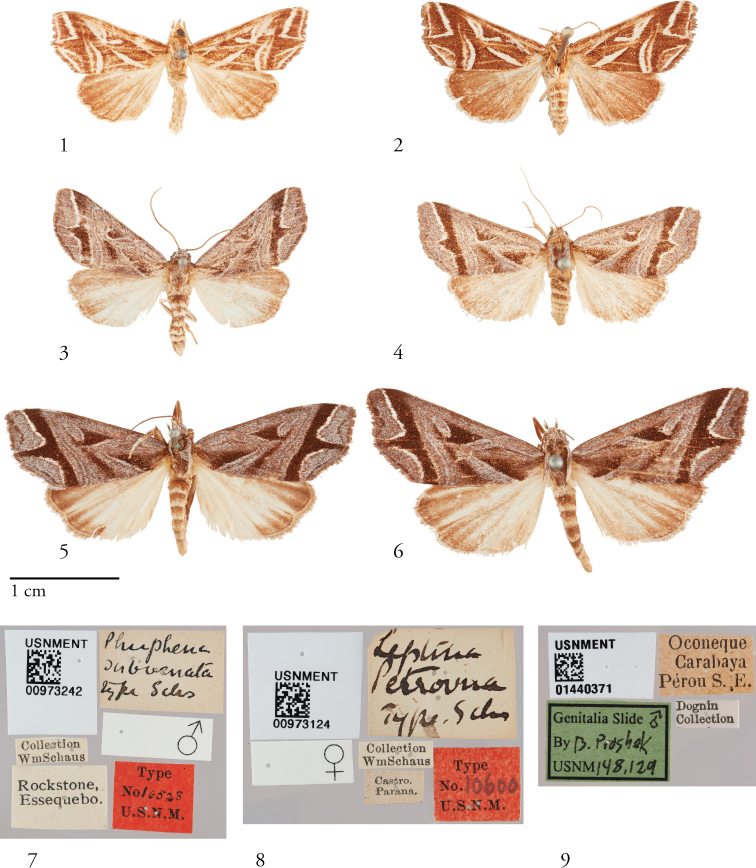
Dorsal habitus of Thraumata species. 1T.
subvenata Holotype ♂, Guyana, USNMENT00973242 2T.
subvenata, USNMENT01440366♀, Suriname 3T.
petrovna ♂ USNMENT01440358, Brazil 4T.
petrovna Holotype ♀ USNMENT00973124, Costa Rica 5T.
peruviensia Holotype ♂ USNMENT01440371, Peru 6T.
peruviensia ♀ USNMENT01440374, Peru 7–9 Holotype specimen labels of Thraumata species 7Phuphena
subvenata Schaus 8Leptina
petrovna Schaus 9Thraumata
peruviensia sp. nov.